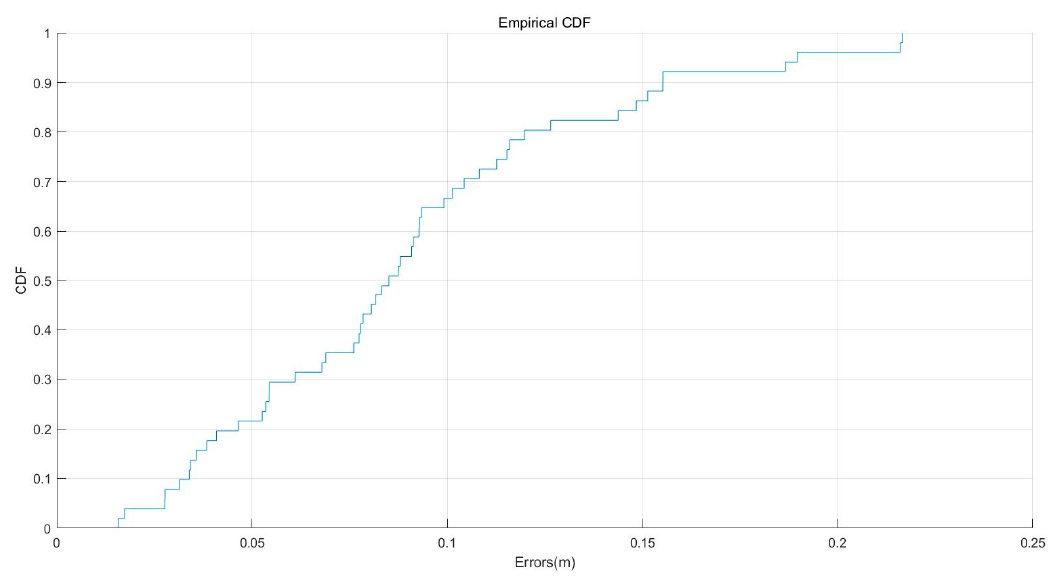
Figure 17. The cumulative distribution function (CDF) curve of the residual errors.